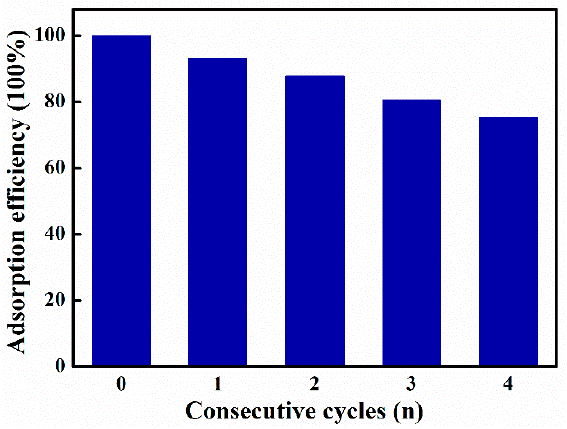
Figure 11. Recycling performance of regenerated zeolitic imidazolate framework-8 (ZIF-8)-loaded UiO-66-NH 2 .